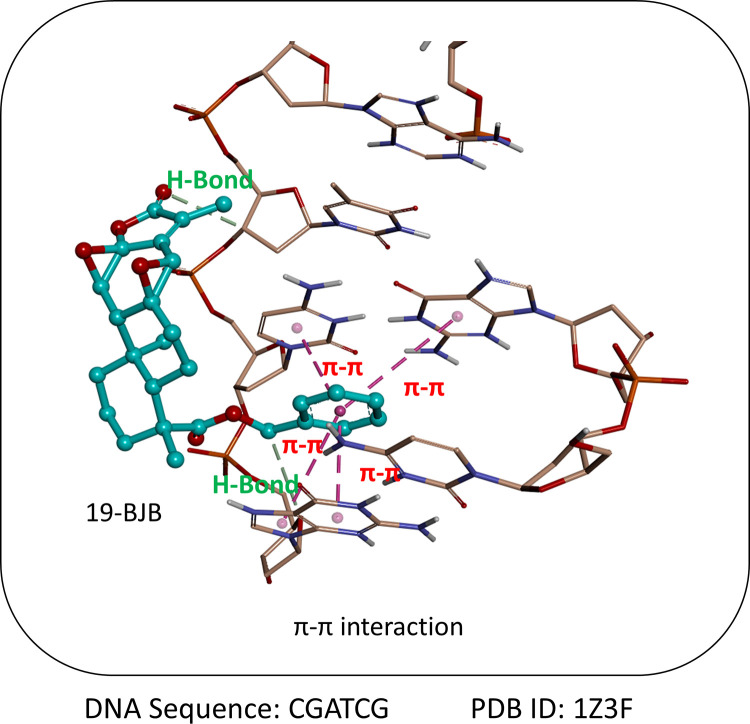
The molecular docking study of 19-BJB and DNA.The figure showed the simulation that 19-BJB bound into the DNA structure (CGATCG) and formed two hydrogen bond interactions and four π-π interactions with each other. The structure of DNA was shown represented in sticks model with atom-based color (brown for C, red for O, blue for N, white for H, and dark brown for P), whereas 19-BJB was represented in sticks model with atom-based color (light blue for C and red for O).